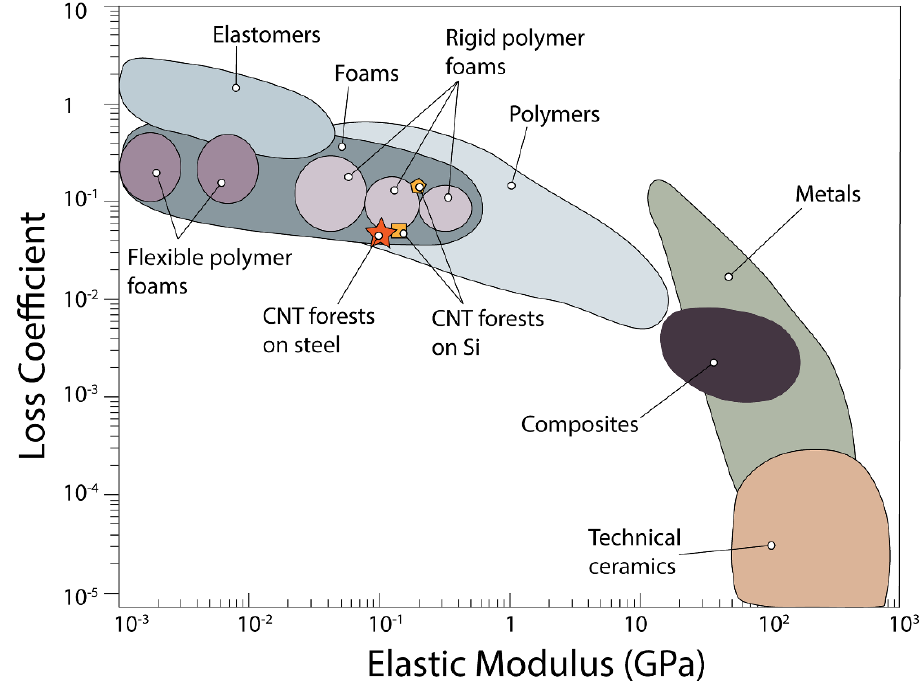
Figure 5. Loss coefficient versus elastic modulus for different material types. The performance of CNT forests on steel is marked by the star symbol, square marker represents CNT forests grown on Si with the same method, and pentagon marker represents CNTs grown on Si through a different method. Data from our work and literature-reported values [10,39].